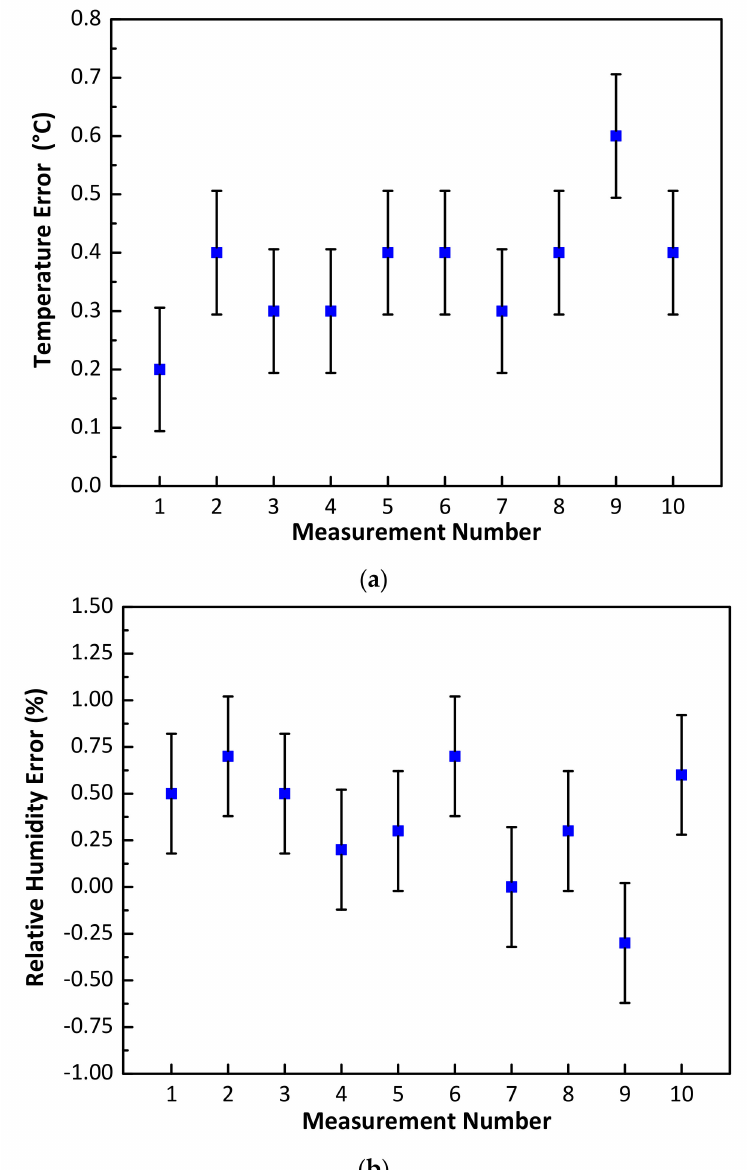
Figure 8. NFC sensor measurement comparison with a calibrated Fluke 971 meter ( a ) temperature error ( ◦ C) and ( b ) Relative humidity error